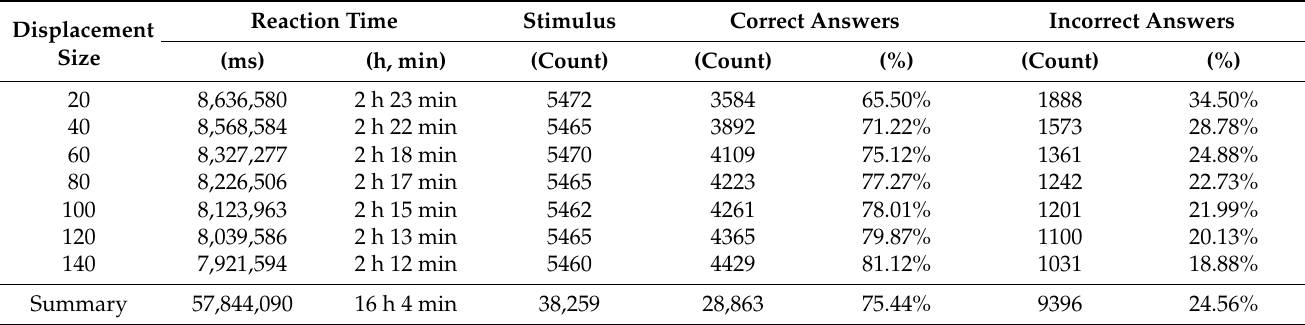
Table 5. Summarized data from the experimental results according to the size of displacement.